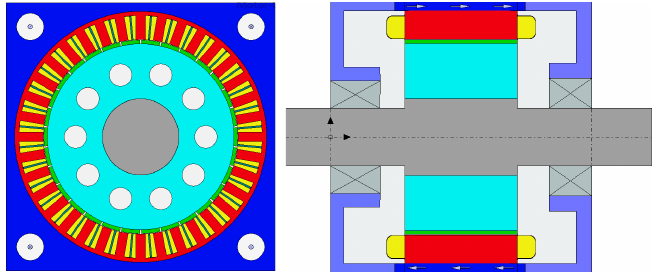
Figure 11. Motor-CAD R (cid:13) Model of the sized machines.